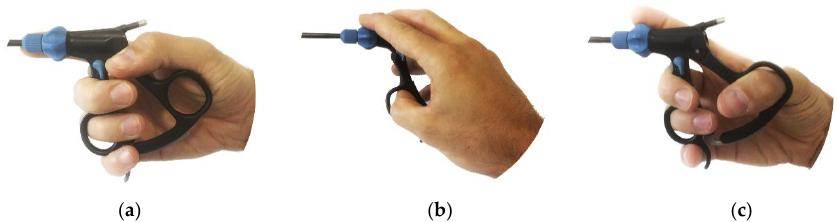
Figure 1. Different forms of gripping the surgical laparoscopic tool according to the surgeon ’ s hand size. The most irregular ones for this grip are the first two ( a , b ). These usually appear when the size of the tool is not adapted to the size of the surgeon ’ s hand. The third ( c ) is the most common, and the information provided directly by the surgeons indicate that it caused the least injuries.